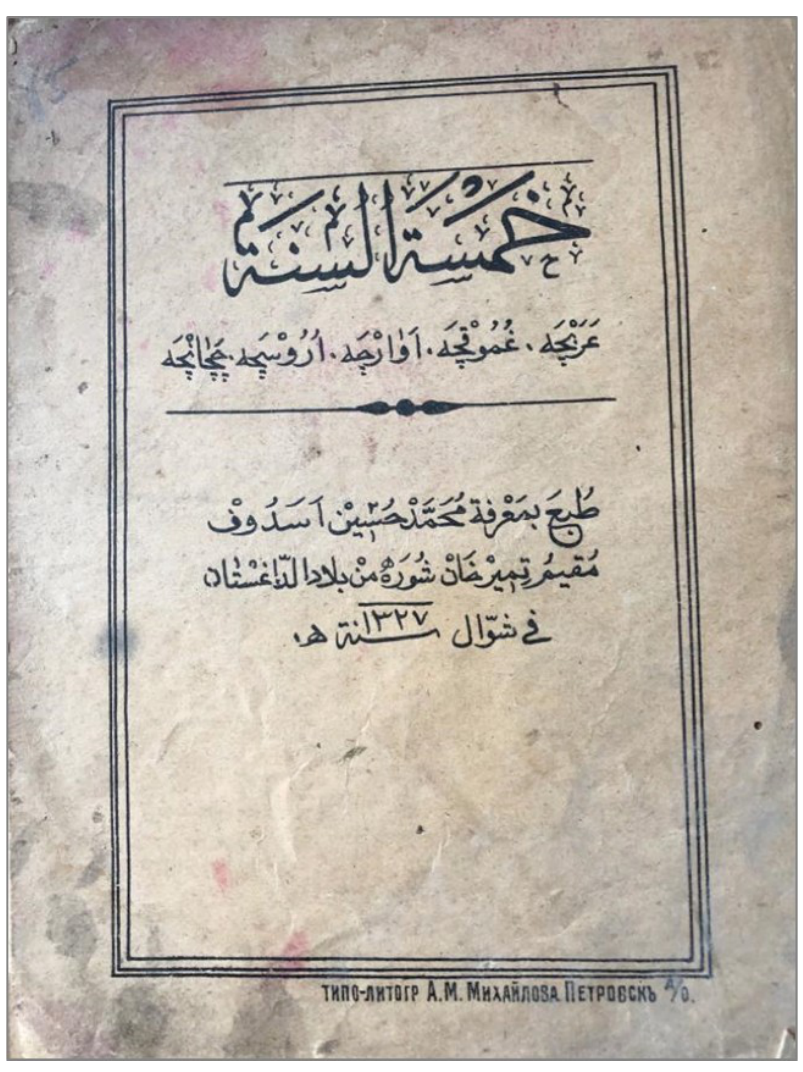
Figure 5 - The five - language dictionary “Hamsat